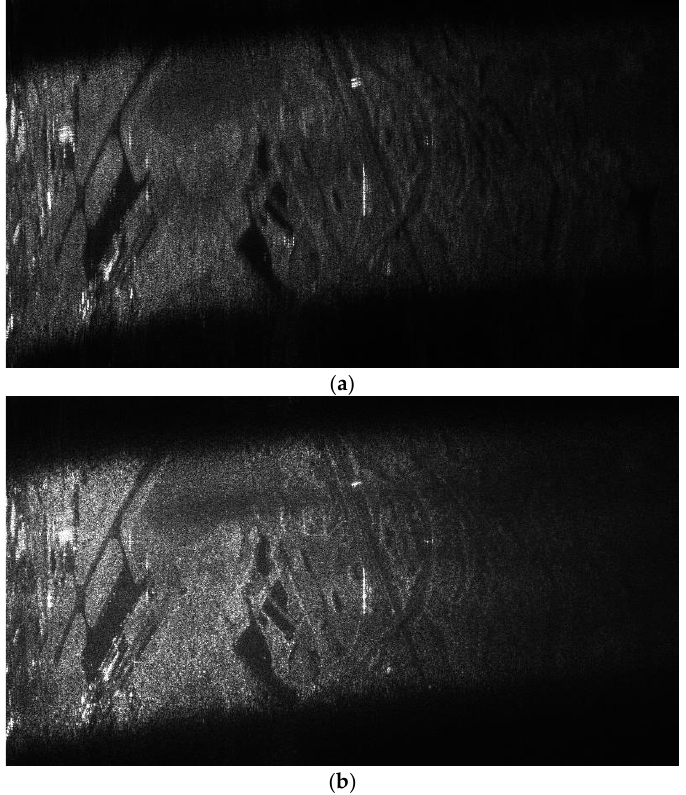
Figure 13. Focusing results of DBF-TOPS SAR in elevation. ( a ) DBF-TOPS SAR result without channel errors’ compensation. ( b ) DBF-TOPS SAR result with channel errors’